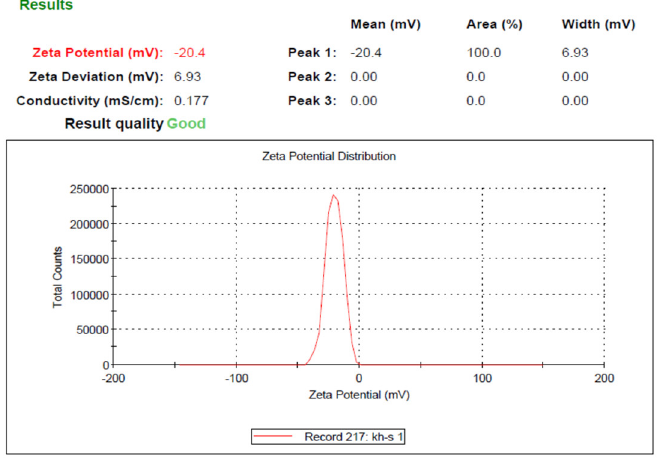
Figure 2. Size distribution of SeN.